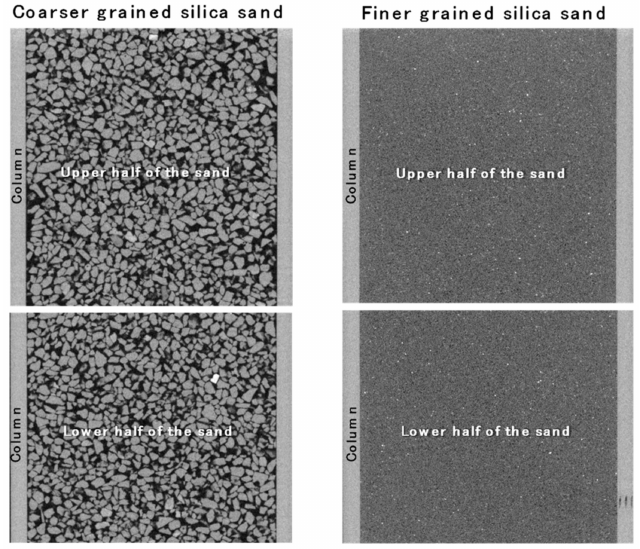
Figure 2. Vertical X-ray computed tomography slice images of upper and lower halves of columns packed with air-dried courser-grained and finer-grained silica